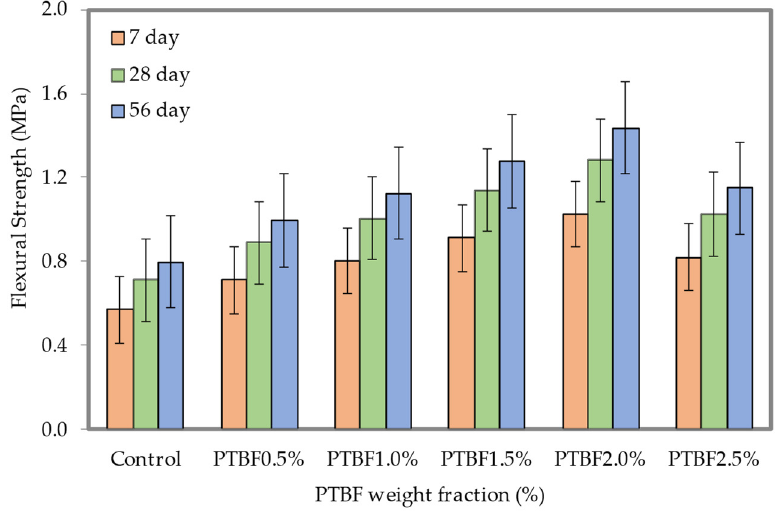
Figure 17. Flexural strength of 900 kg/m 3 density LFC with different weight fractions of PTBF.